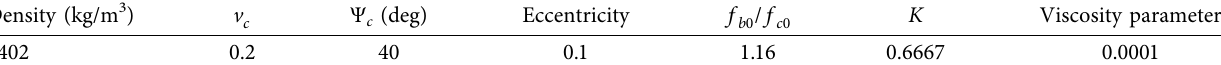
Table 4: CDP parameters.